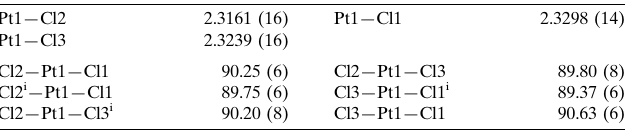
Selected geometric parameters (A˚ , (cid:3) ).